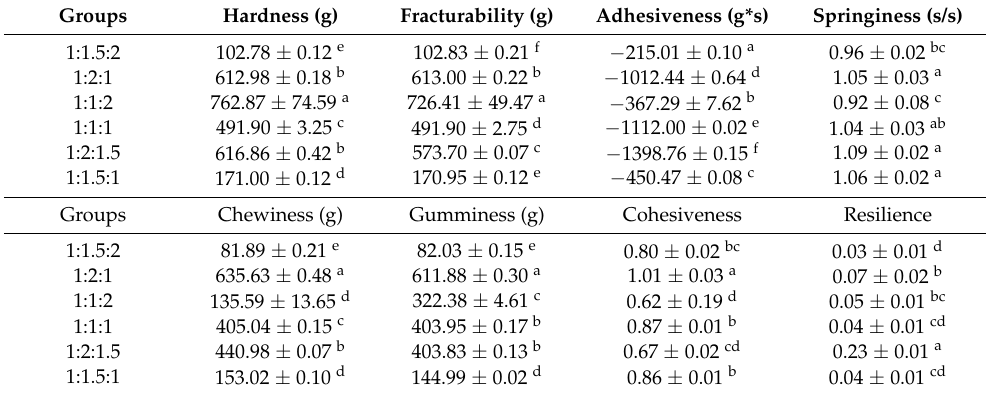
Table 4. Texture profile analysis of black garlic jam with different ratios by HPP